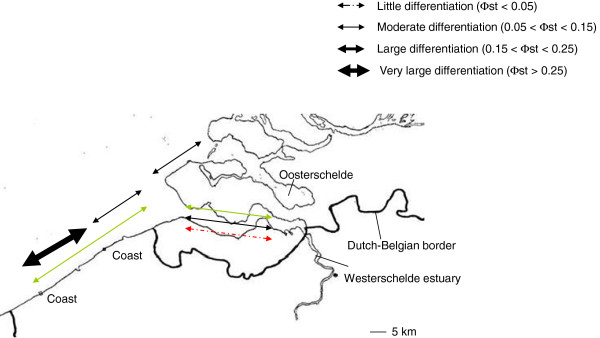
Genetic structuring in marine nematodes at small geographic scale (<100 km). The sampling area encompasses the Westerschelde estuary and the Oosterschelde in The Netherlands, and two Belgian coastal locations. The strength of differentiation is based on [53]. Black arrows: Litoditis marina; Green arrows: Halomonhystera disjuncta; Red arrow: Bathylaimus assimilis.